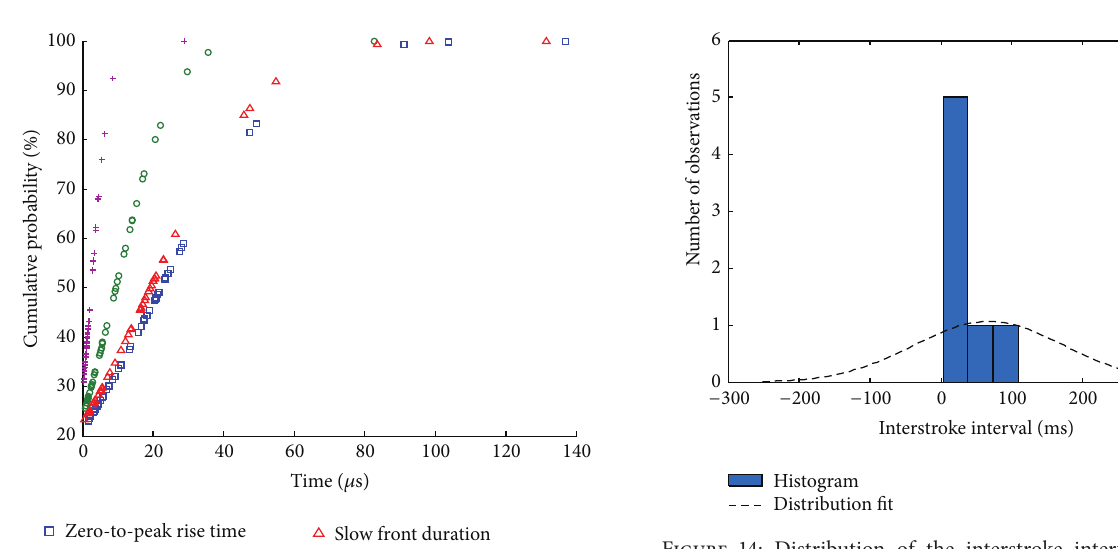
Figure 14: Distribution of the interstroke interval for positive ground